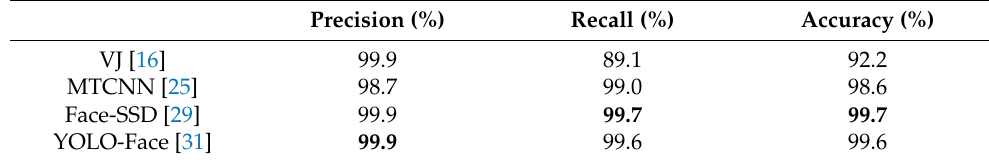
Table 2. Detection results on the CelebA dataset.